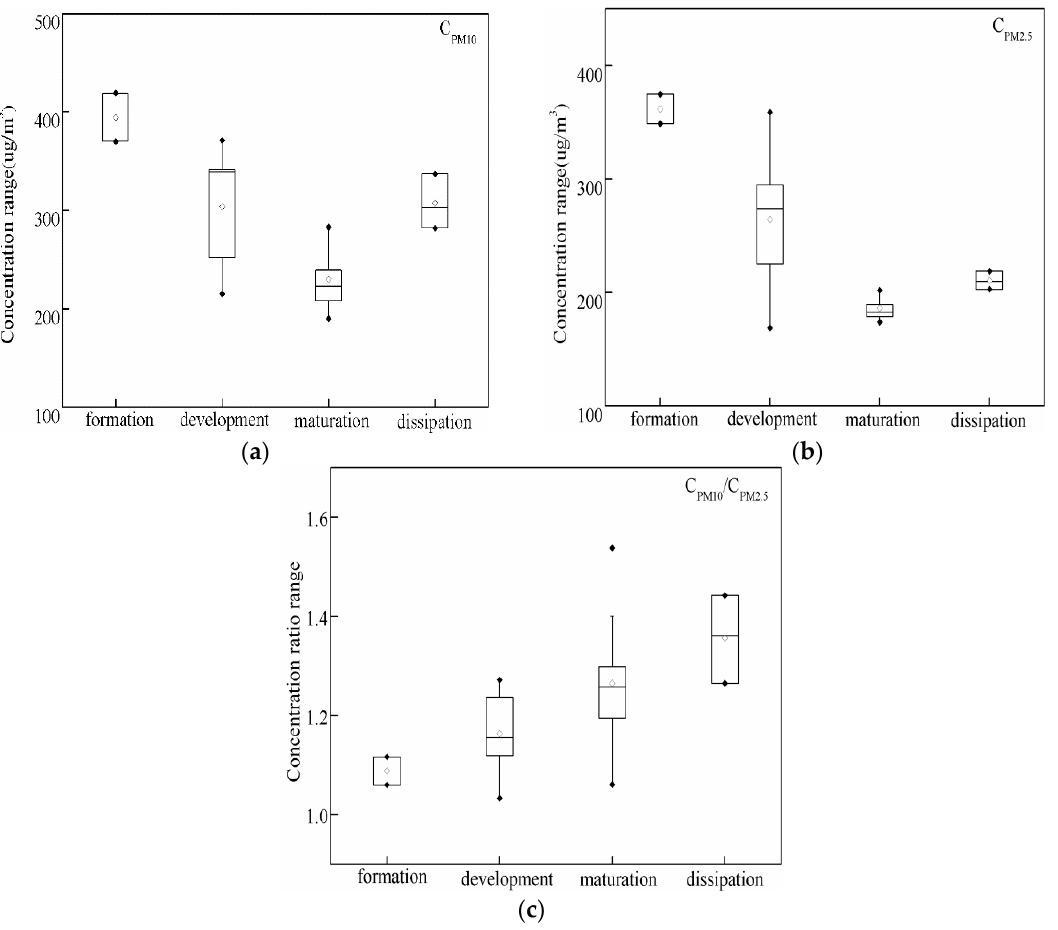
Figure 7. Changes of C PM10 ( a ), C PM2.5 ( b ), and C PM10 /C PM2.5 ( c )during the four stages in Case 2.